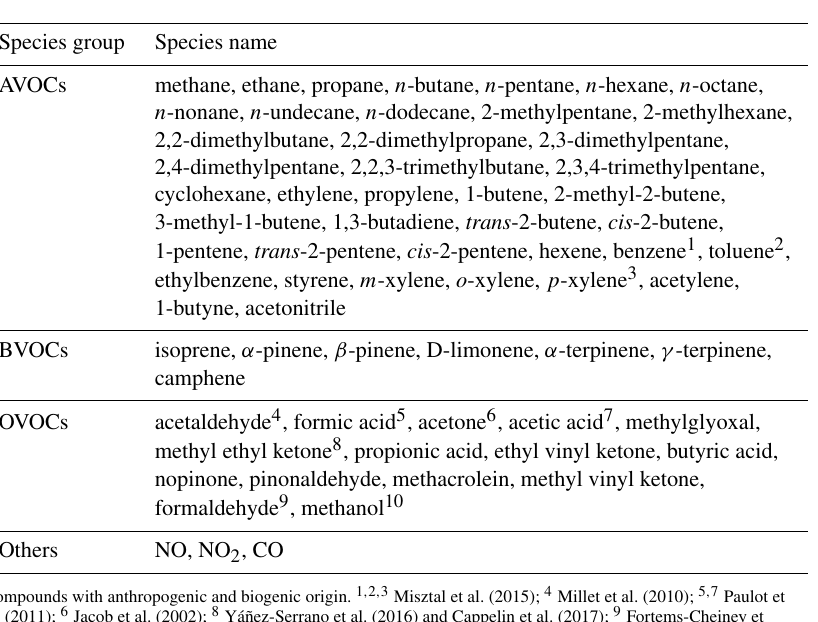
Table 1. Measured compounds (whose concentration was above the instrumental detection limits) and their adopted classification in the paper for calculating the OH reactivity. Anthropogenic VOCs, BVOCs and OVOCs stand respectively for anthropogenic, biogenic and oxygenated volatile organic